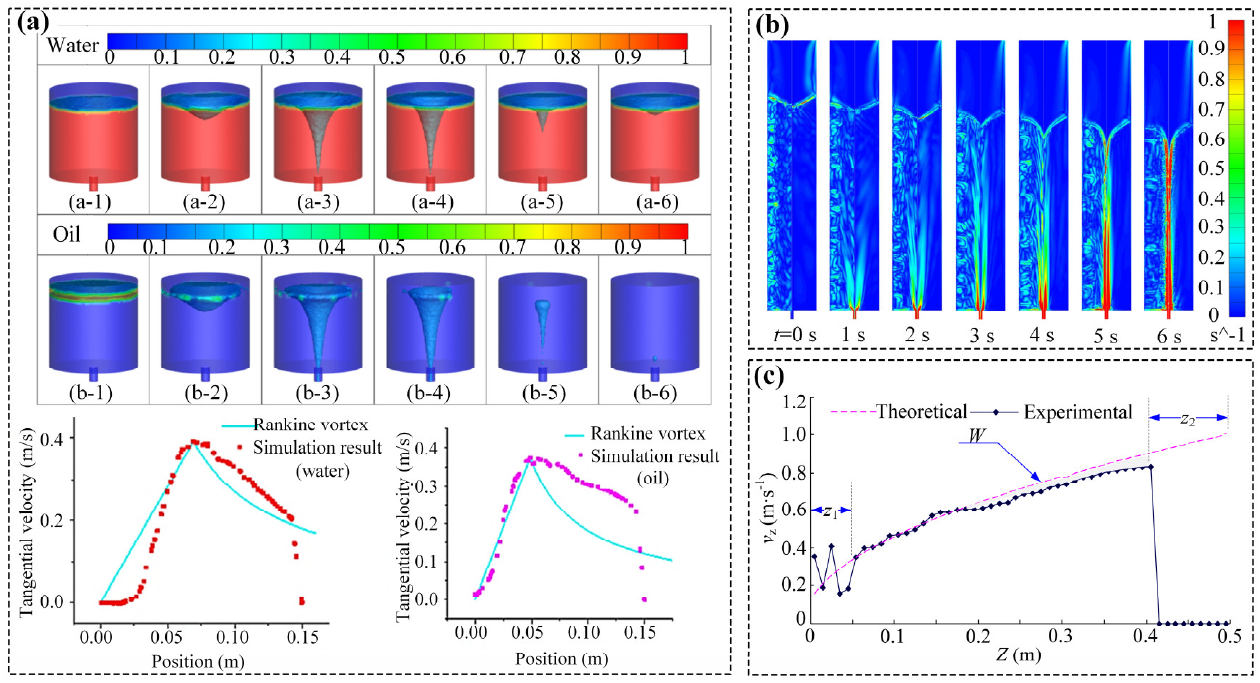
Figure 5. Flow features of the free surface vortex. ( a ) Fluid volume fraction and tangential velocity. (Reprinted with permission from Ref. [56]. 2020, Elsevier.) ( b ) Tangential vorticity contours. Reproduced with the permission of Springer Nature. (Reprinted with permission from Ref. [59]. 2019, Springer Nature.) ( c ) Axial disturbance velocity. Reproduced with the permission of Elsevier. (Reprinted with permission from Ref. [60]. 2019, Springer Nature.)